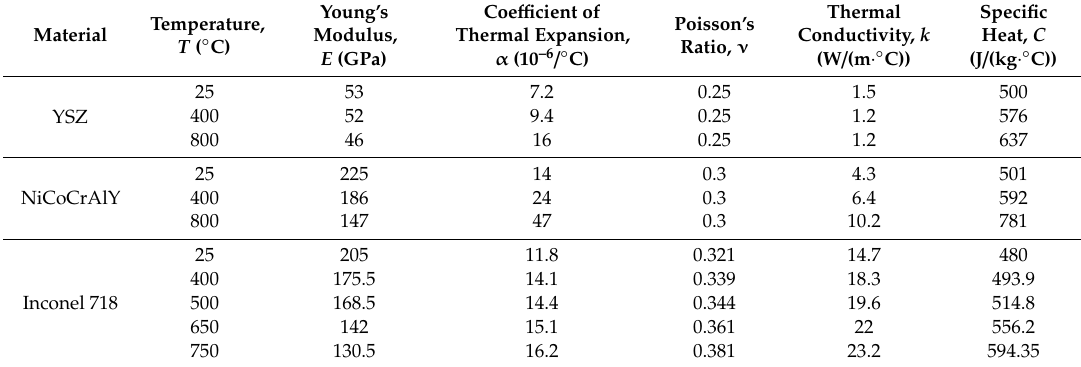
Table 2. Temperature-dependent material properties used in the FE model [25,26].